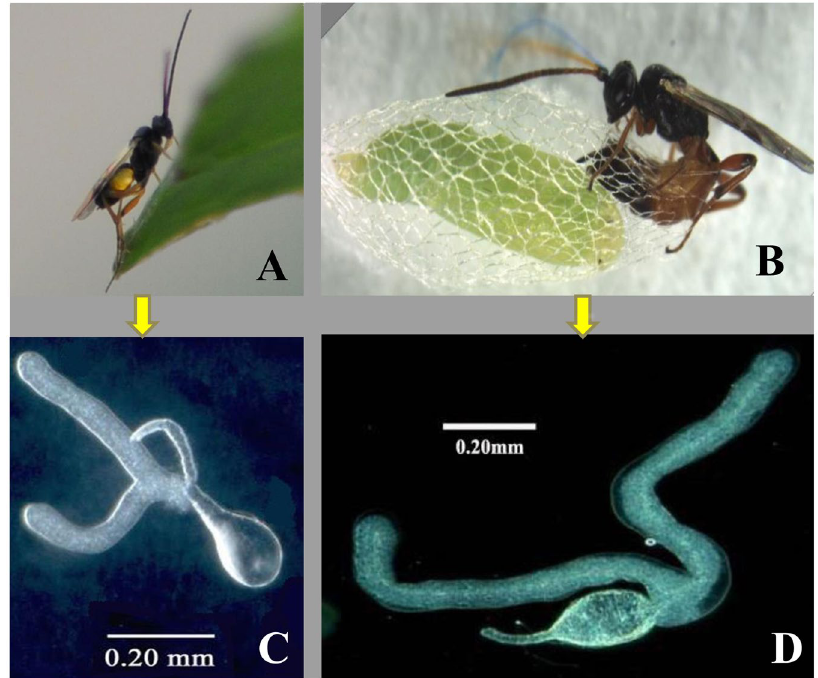
Figure 1. Two wasps and their venom apparatuses. ( A ) and ( C ) C . vestalis and its venom apparatus. ( B ) and ( D ) D . collaris and its venom